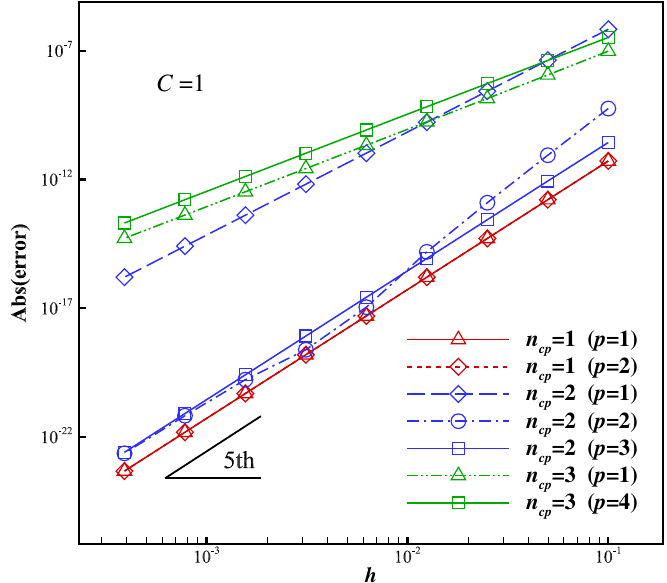
Figure 3. The error of g (cid:48) n ( 0 )( n = 2,3,4 ) calculated by ˆ (cid:101) adp